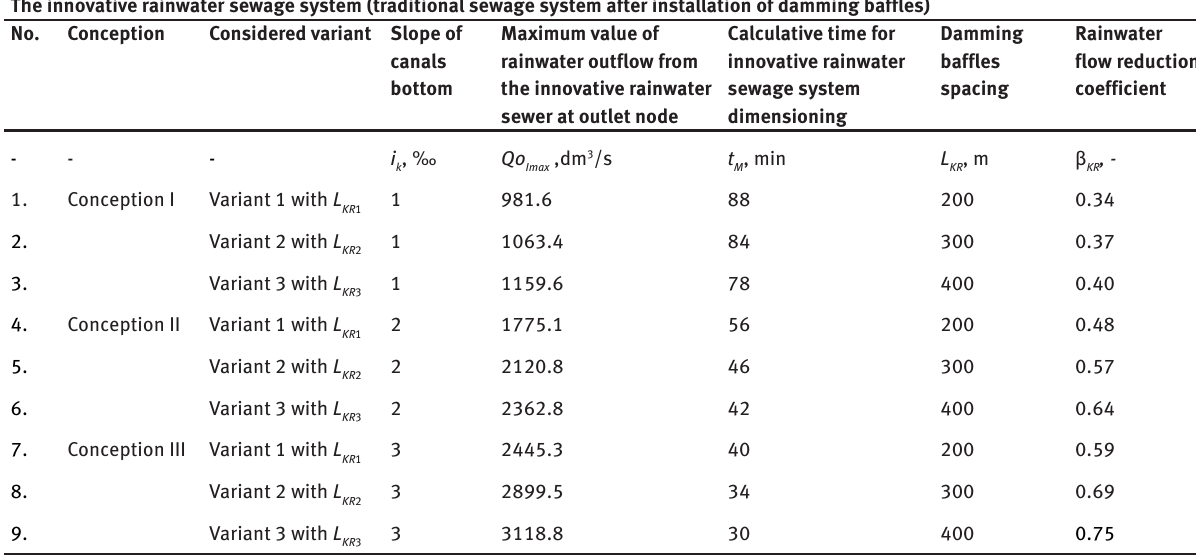
Table 2: A Set of the values of the basic hydraulic parameters of the innovative rainwater sewage with retention canals system. The innovative rainwater sewage system (traditional sewage system after installation of damming baffles)